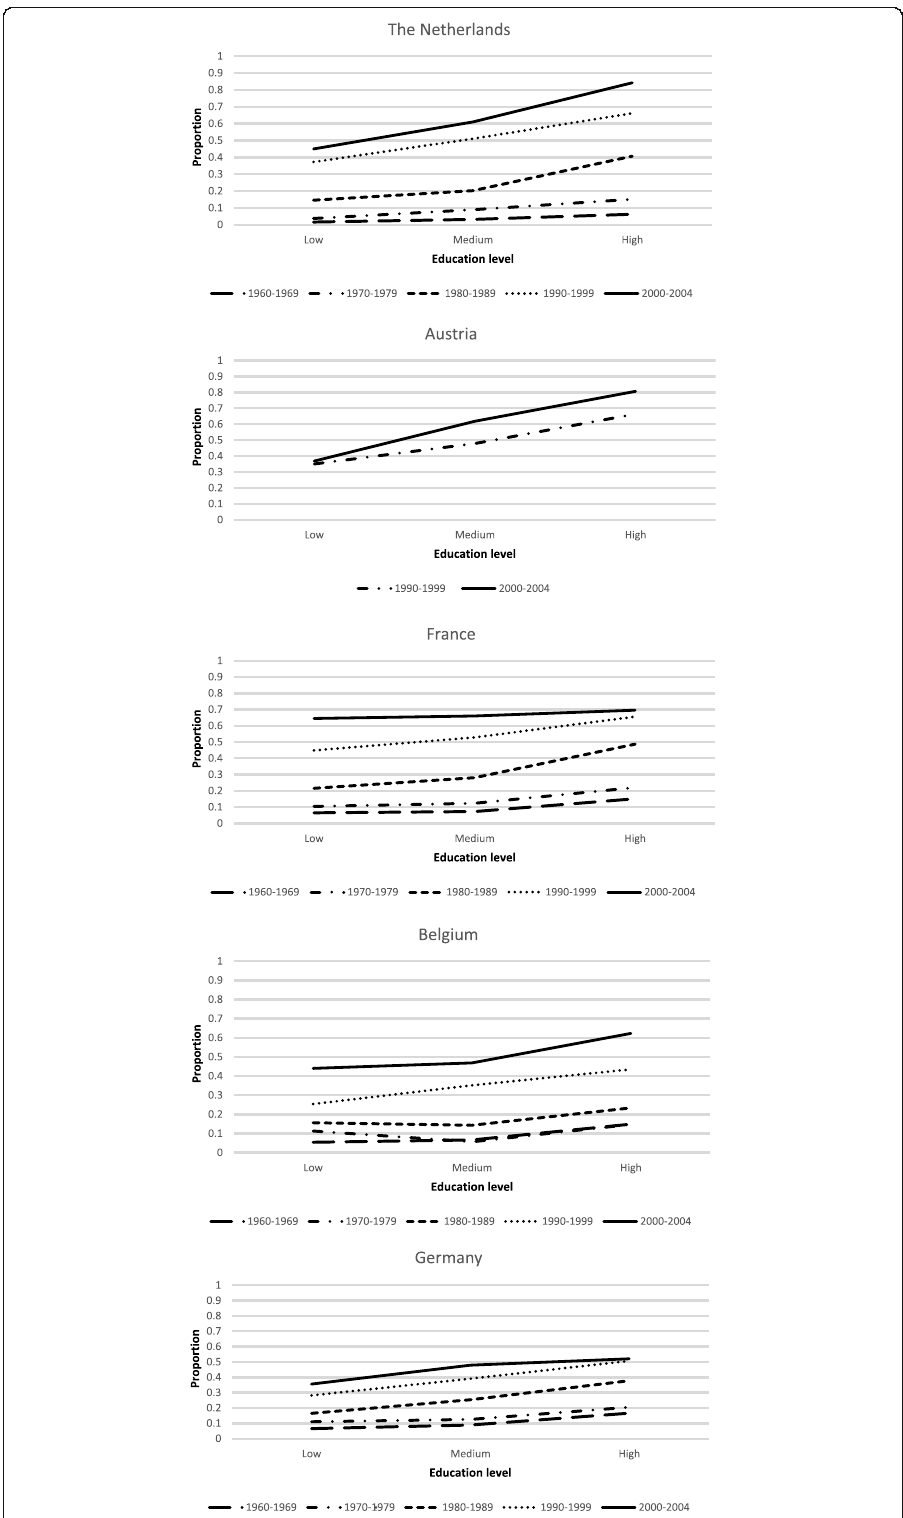
Fig. 6 Expansion of cohabitation by level of education in selected European countries — share of cohabitation for at least 1 year relative to all women 25 – 29 who were in a union (married + cohabiting) for at least 1 year. Source: Courtesy of Jorik Vergauwen, Antwerp University. Data: Gender and Generation Survey harmonised data and national